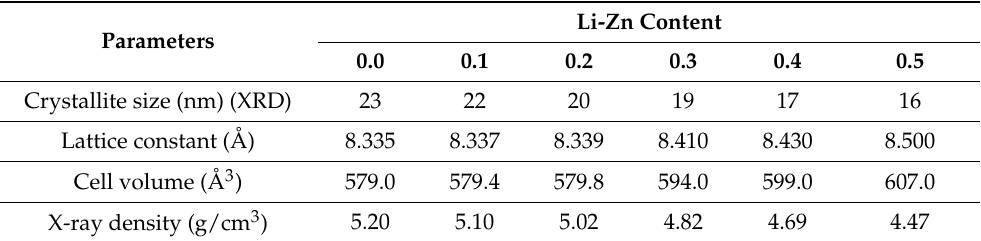
Table 1. Structural parameters calculated for pure cobalt ferrite ( x = 0) and doped CoFe 2 − 2x Li x Zn x O 4 ( x = 0.1–0.5) nano powder.